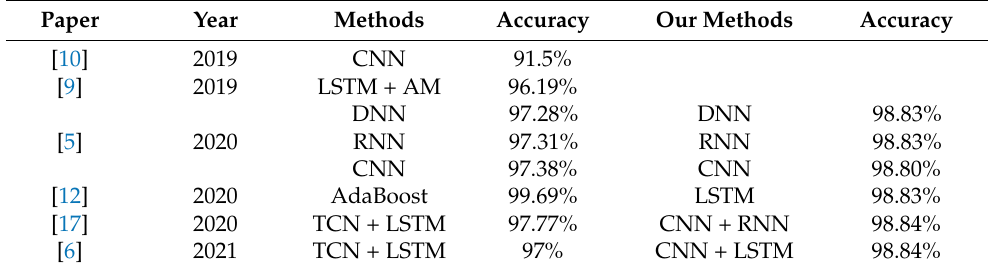
Table 28. Comparison with related literature based on the CSE-CIC-IDS2018 dataset.